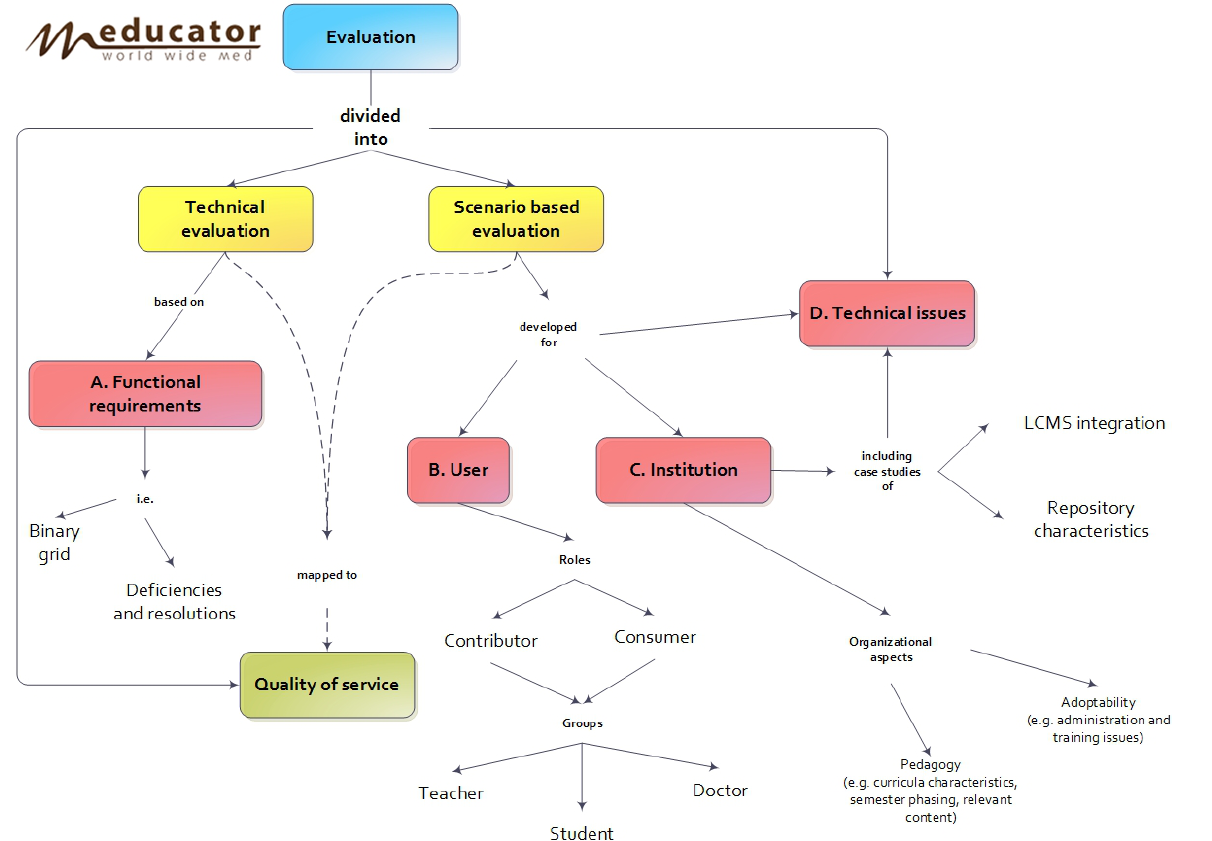
Figure 2. Overview of the evaluation framework developed for the mEducator system, dividing evaluation into technical evaluation and scenario-based